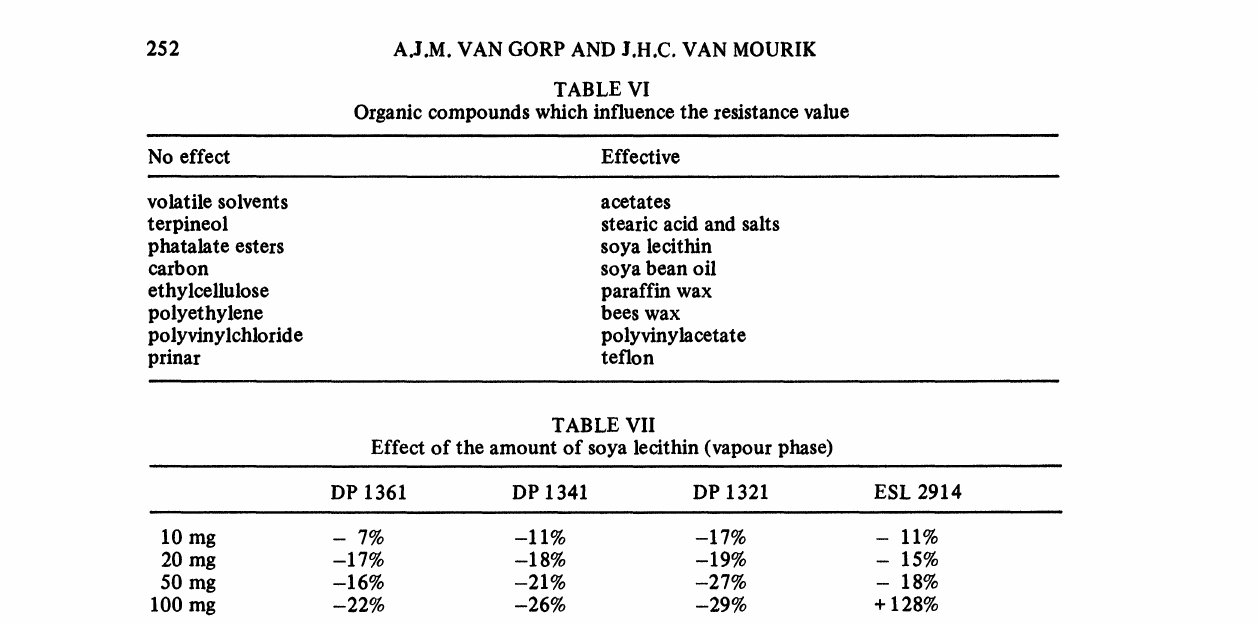
TABLE VI Organic compounds which influence the resistance value No